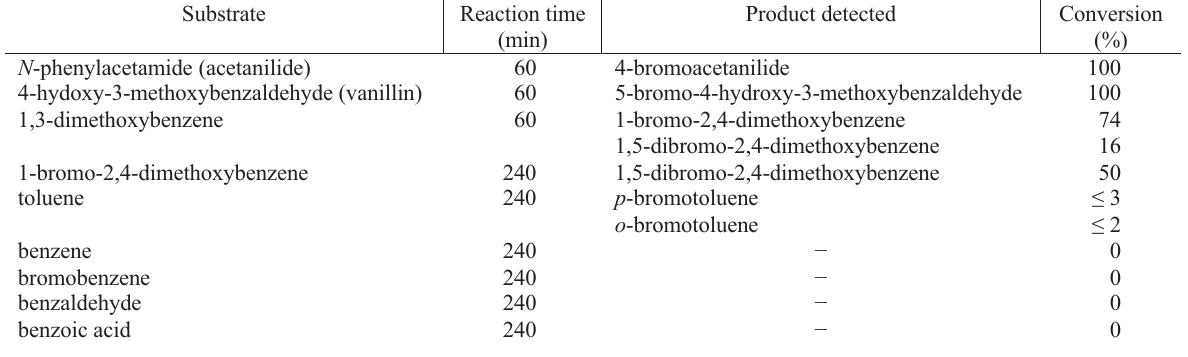
Table 2. Bromination experiments with activated and deactivated aromatic compounds using the solvent free bromination method. Reactions were conducted using 5 mmol of bromination substrate, 11 mmol of KNO 3 and at constant flow of